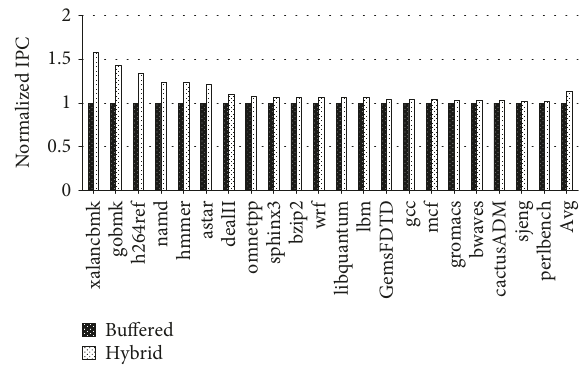
Figure 17: Normalized IPC of 64 threads with one thread per core.